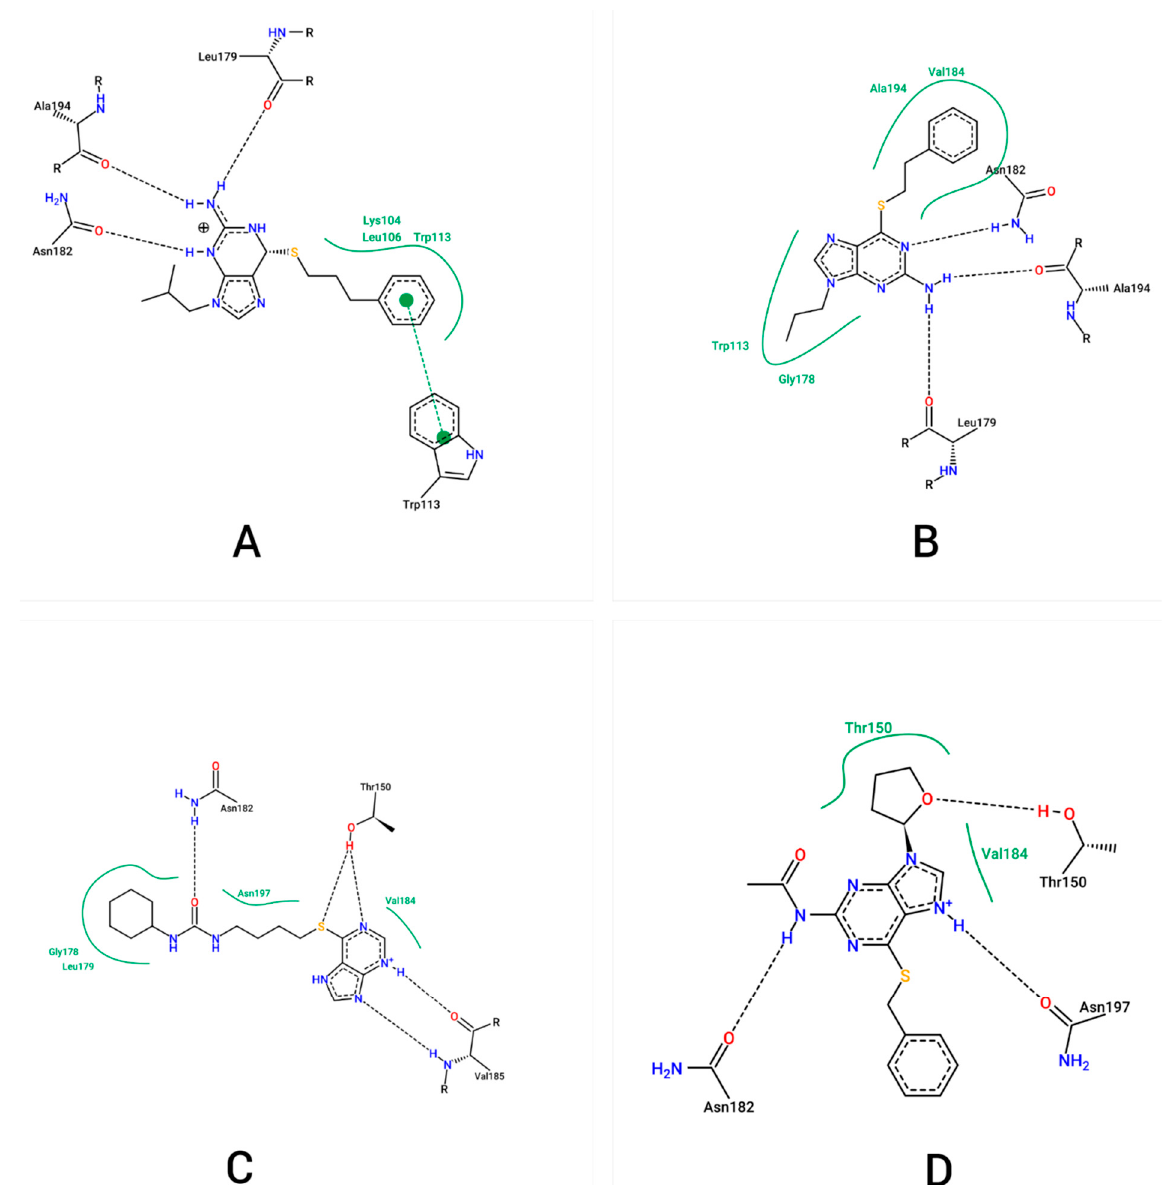
Figure 1. Predicted interactions in the docking with the NS2B/NS3pro enzyme of the ligands ZINC GOLD program. The dashed black lines represent the hydrogen bonds and the green lines represent the hydrophobic interactions. The images were obtained through the PoseView Web 1.97